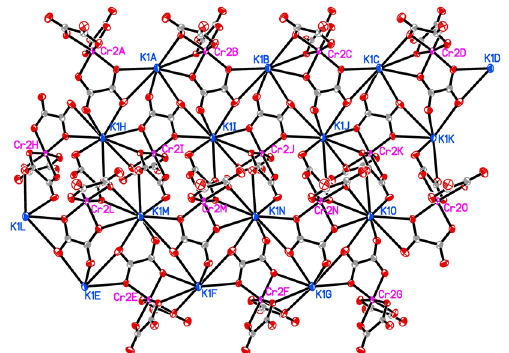
Figure 3. The 2D supramolecular structure of the layer formed by [Cr(C O ) ] 3− anions and K + cations, which are parallel to 2 4 3 the Y and Z crystallographic axes. Atoms are displayed as gray, red, pink and blue ellipsoids for carbon, oxygen, chromium and potassium, respectively. Metal centres are labelled for clarity.